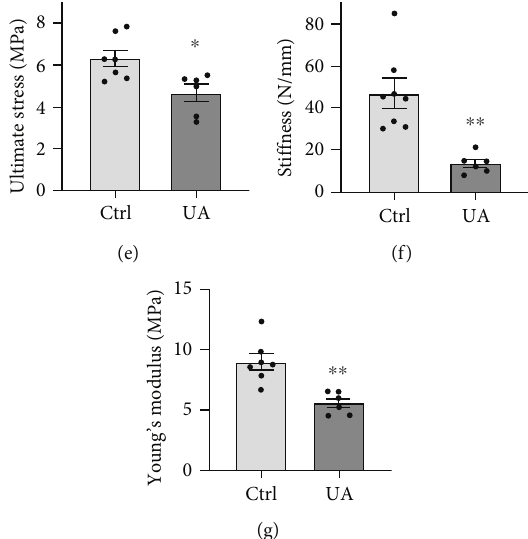
Figure 4: Characterization of the AT tissue from the experimental rat model of hyperuricemia. (a – c) Representative sections of AT from rats intragastrically administered with 0.5% sodium carboxymethylcellulose ( n = 5 ) or UA ( n = 6 ). Tendon tissues showed remarkable di ff erences in the morphology by hematoxylin and eosin staining ((a), left) and in the collagen expression by Masson ’ s trichrome (MT) staining ((a), middle) and Sirius red staining ((a), right). Bars = 50 μ m . (b, c) Representative sections were stained for CD3 (b) and CD68 (c) in red, and nuclei were stained with Hoechst 33258 (blue). Bars = 100 μ m . (d – g) Comparison of mechanical testing results of the rat AT tissue postinduction of UA ( n = 6 ) or the vehicle control ( n = 7 ) in the failure load (d), the ultimate stress level (e), the sti ff ness (f), and the levels of Young ’ s modulus (g). Values are the mean ± SEM of average data from 2 independent experiments. ∗ P < 0 : 05 ; ∗∗ P < 0 : 01 versus vehicle